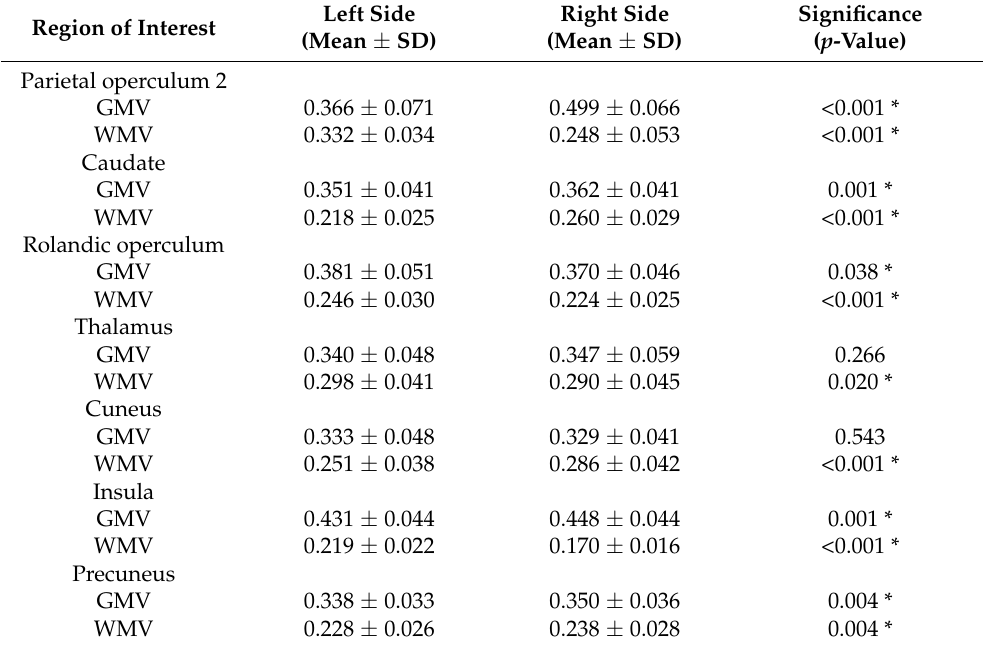
Table 1. Results of Statistical Analyses of Gray-Matter Volume (GMV) and White-Matter Volume (WMV) of the Central-Vestibular System in Healthy Individuals a .